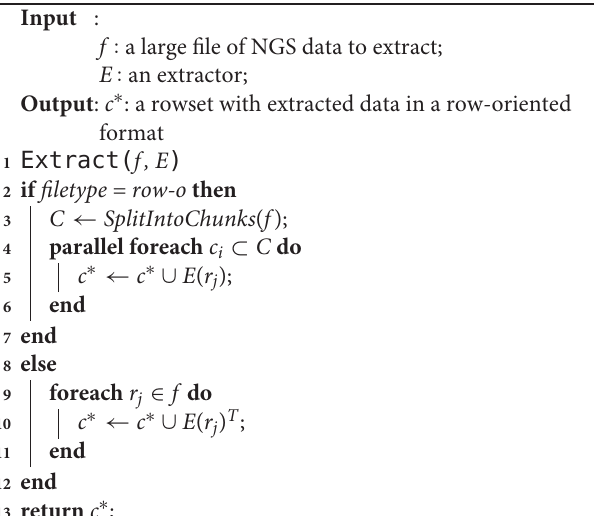
Algorithm 1: NGS data extraction for a single file located in big NGS data